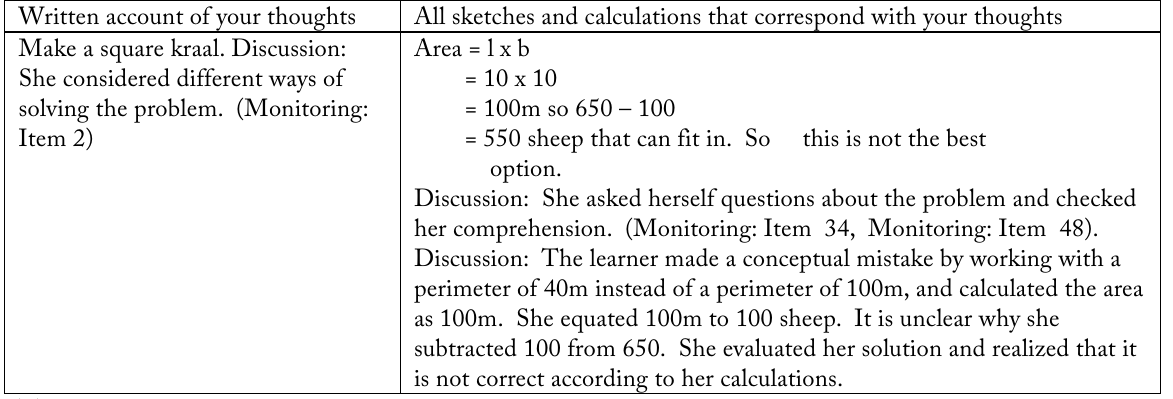
Table 1: An excerpt from a learner’s response to the problem statement.